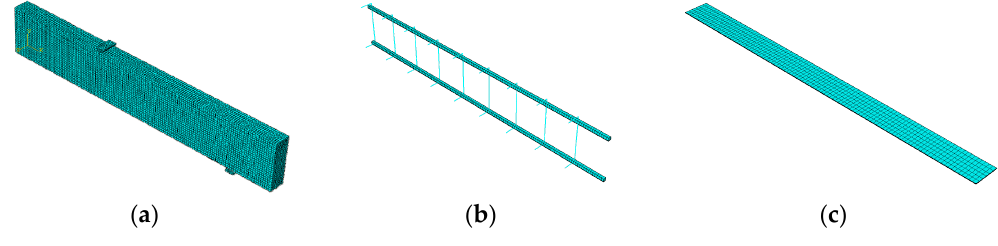
Figure 9. FE model: ( a ) concrete; ( b ) steel; ( c ) FRP.